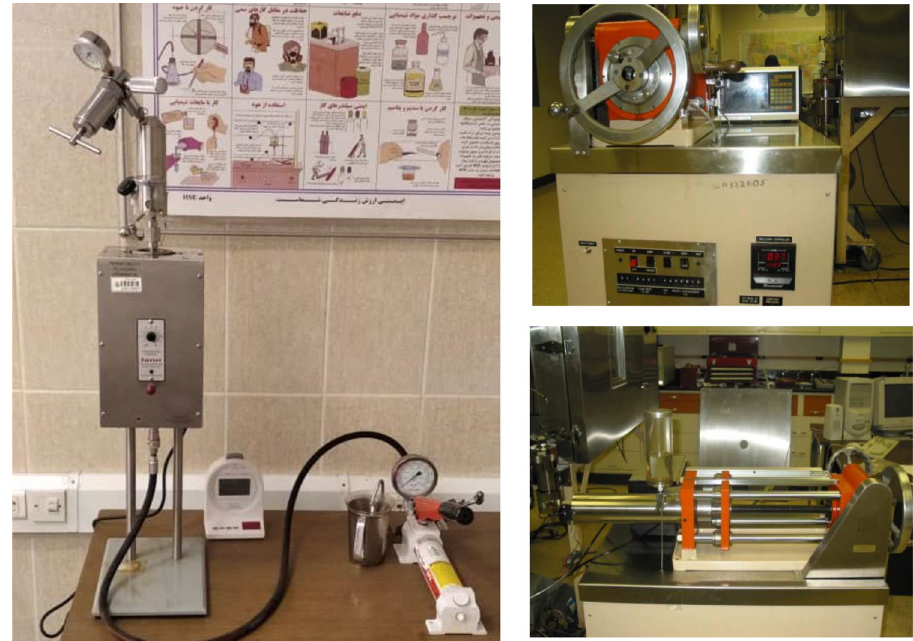
Fig. 5 LCM testing